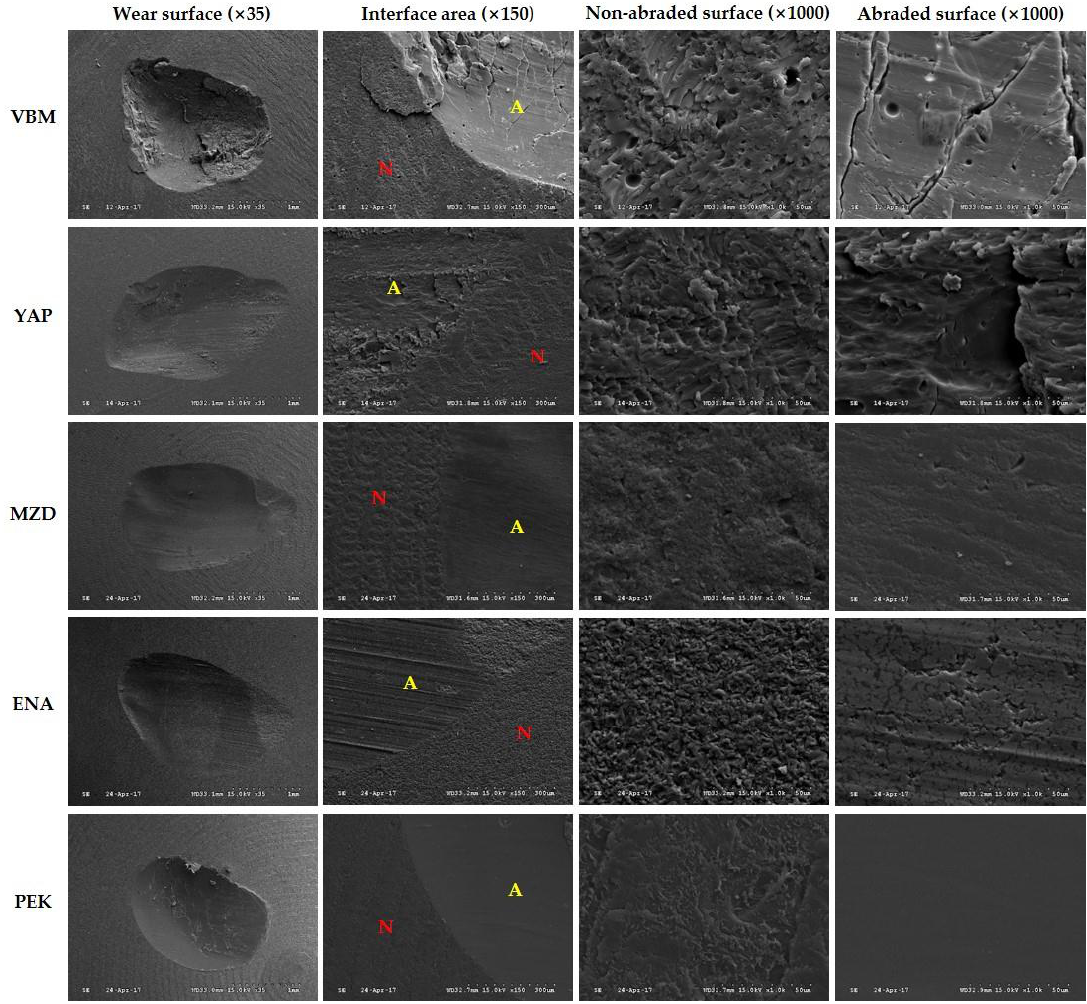
Figure 4. Scanning electron micrographs of restorative material specimens after 120,000 chewing